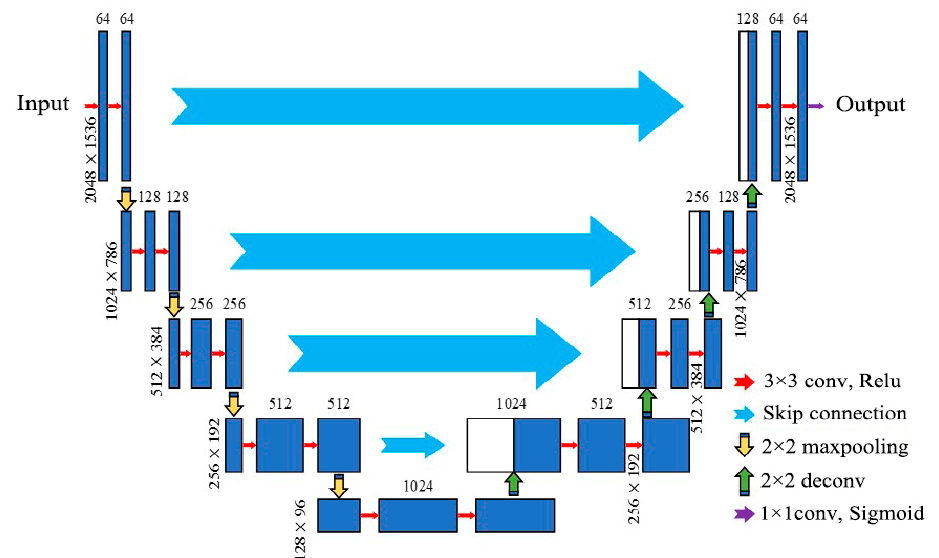
Figure 1. Structure of the U-net neural network.